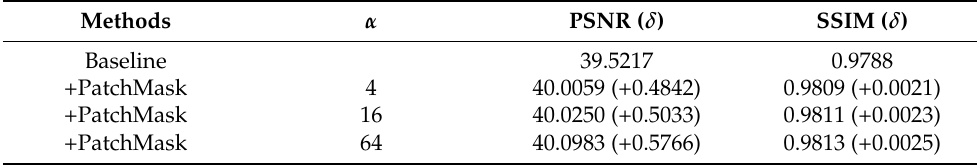
Table 5. The impact of the total number of patches on the network. Best scores are